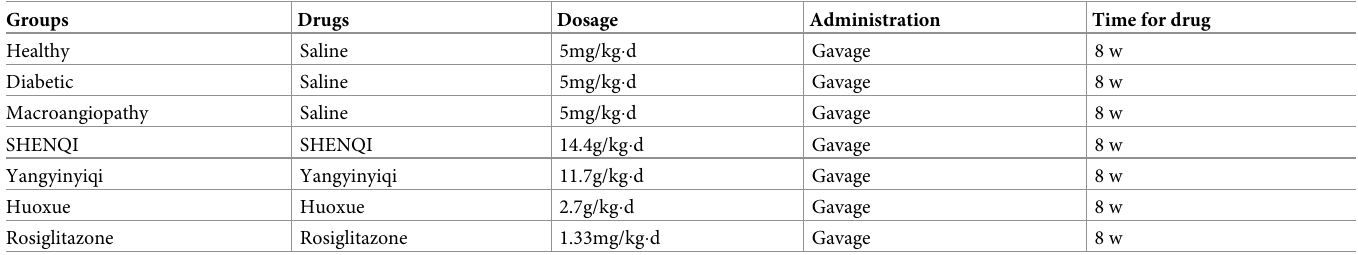
Table 1. Processing conditions of each model